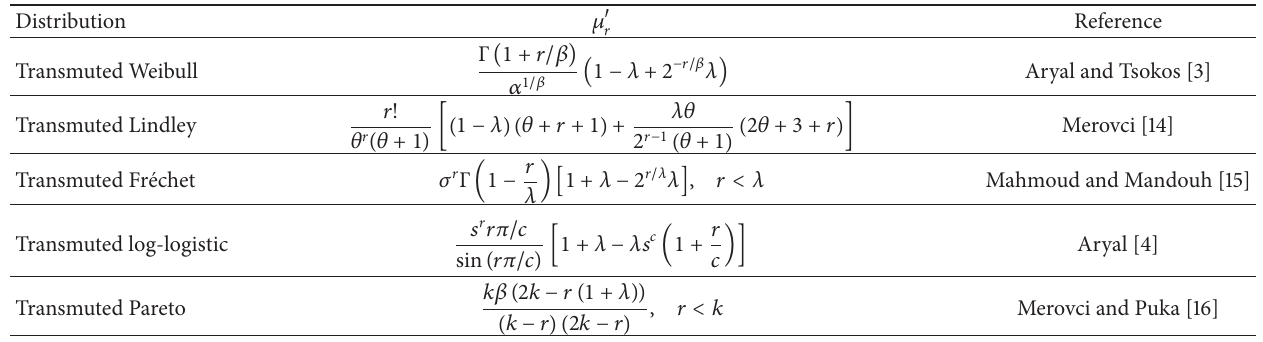
Table 2: Distributions and their